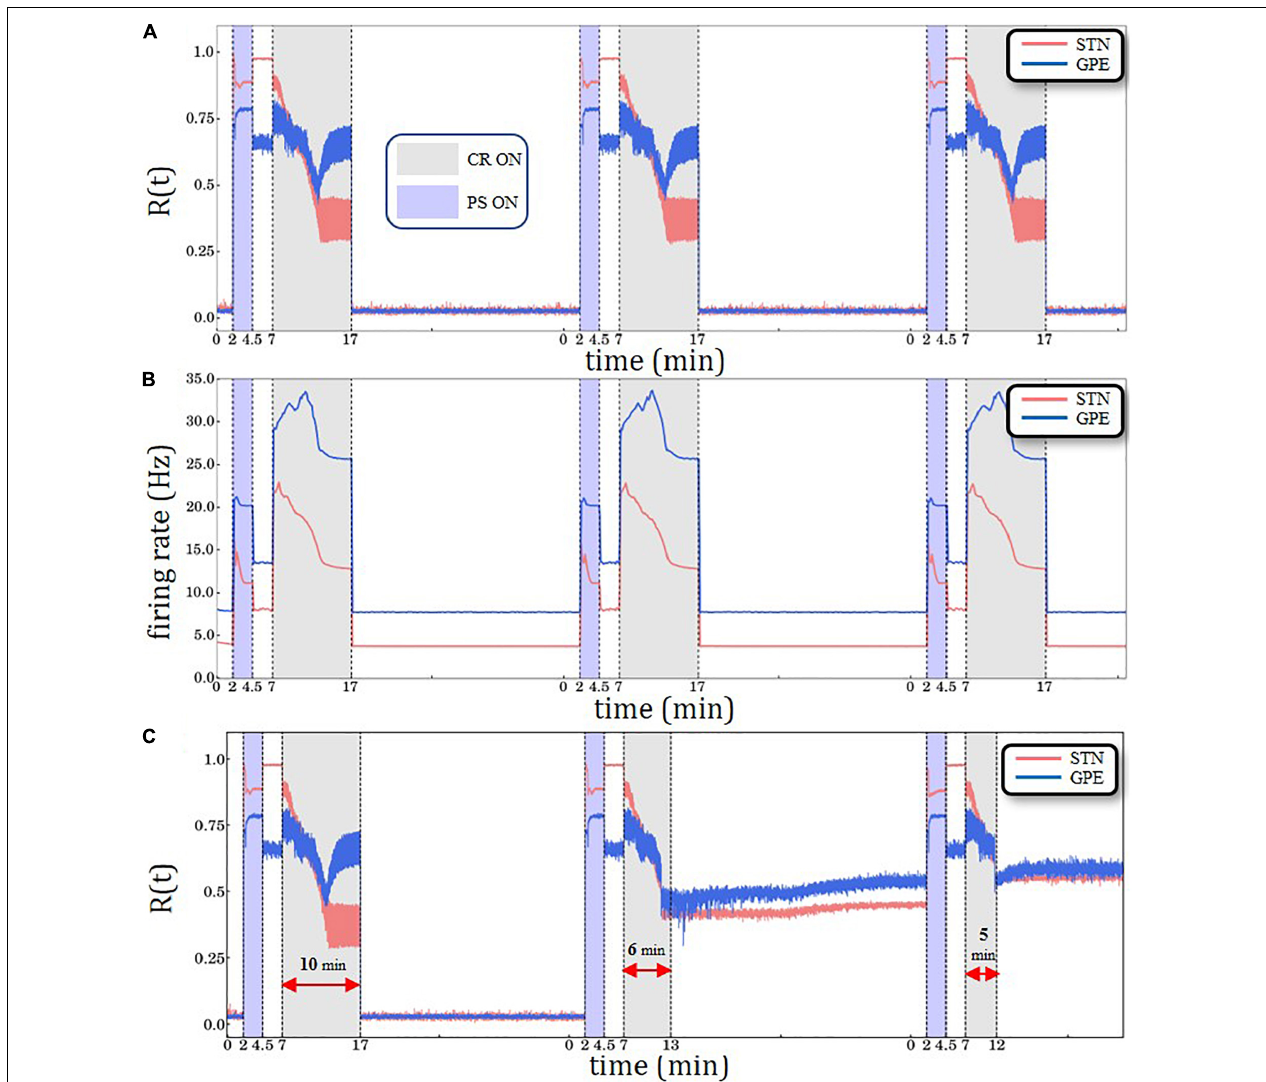
FIGURE 3 | Periodic Stimulation (PS)-CR sequences without structural plasticity. (A) Time evolution of the order parameter R ( t ) averaged over a sliding window (10 ms) for STN (red solid line) and GPe (blue solid line) neurons. (B) Spiking rates for STN and GPe neurons for three identical CR periods. Light blue bands denote the PS (2.5 min) intervals and light gray the CR intervals (10 min). STDP is active throughout the entire trial. The synchronization-desynchronization process caused by the first PS-CR sequence is repeated by the two subsequent PS-CR sequences, indicating its reproducibility in the absence of PS. (C) PS-CR sequence with one long CR epoch followed by two PS-CR sequences with insufficient CR duration (6 and 5 min, respectively) without structural plasticity.